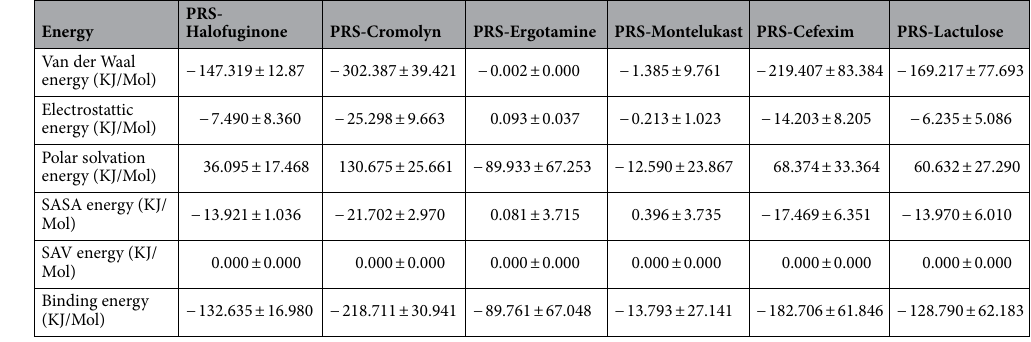
Table 5. The Van der Waals, electrostatic, polar solvation, SASA, SAV, and binding energies of the Cromolyn- PRS, Ergotamine-PRS, Montelukast-PRS, Cefexim-PRS, Lactulose-PRS complexes (kJ/mol), calculated by the MMPBSA method.